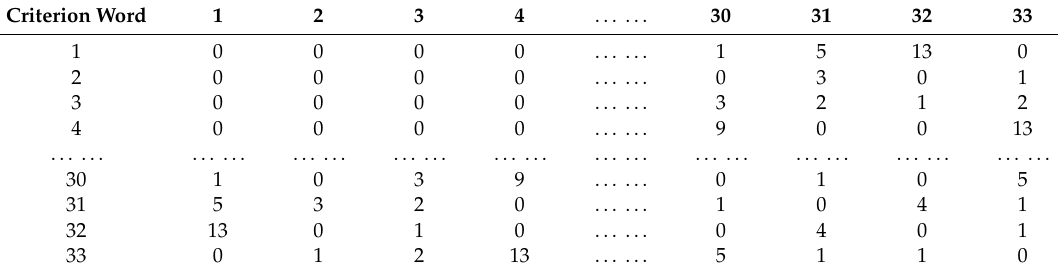
Table 4. Criterion word clustering